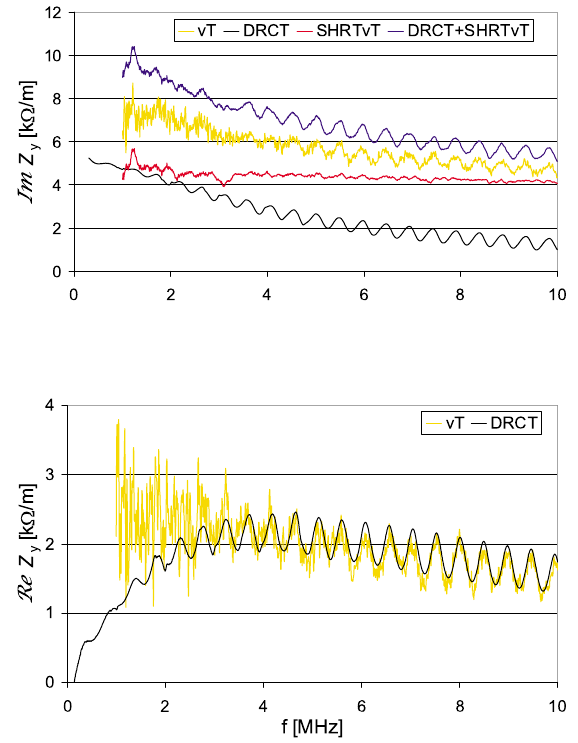
system.FIG. 19. (Color) Vertical impedance of kicker system at low